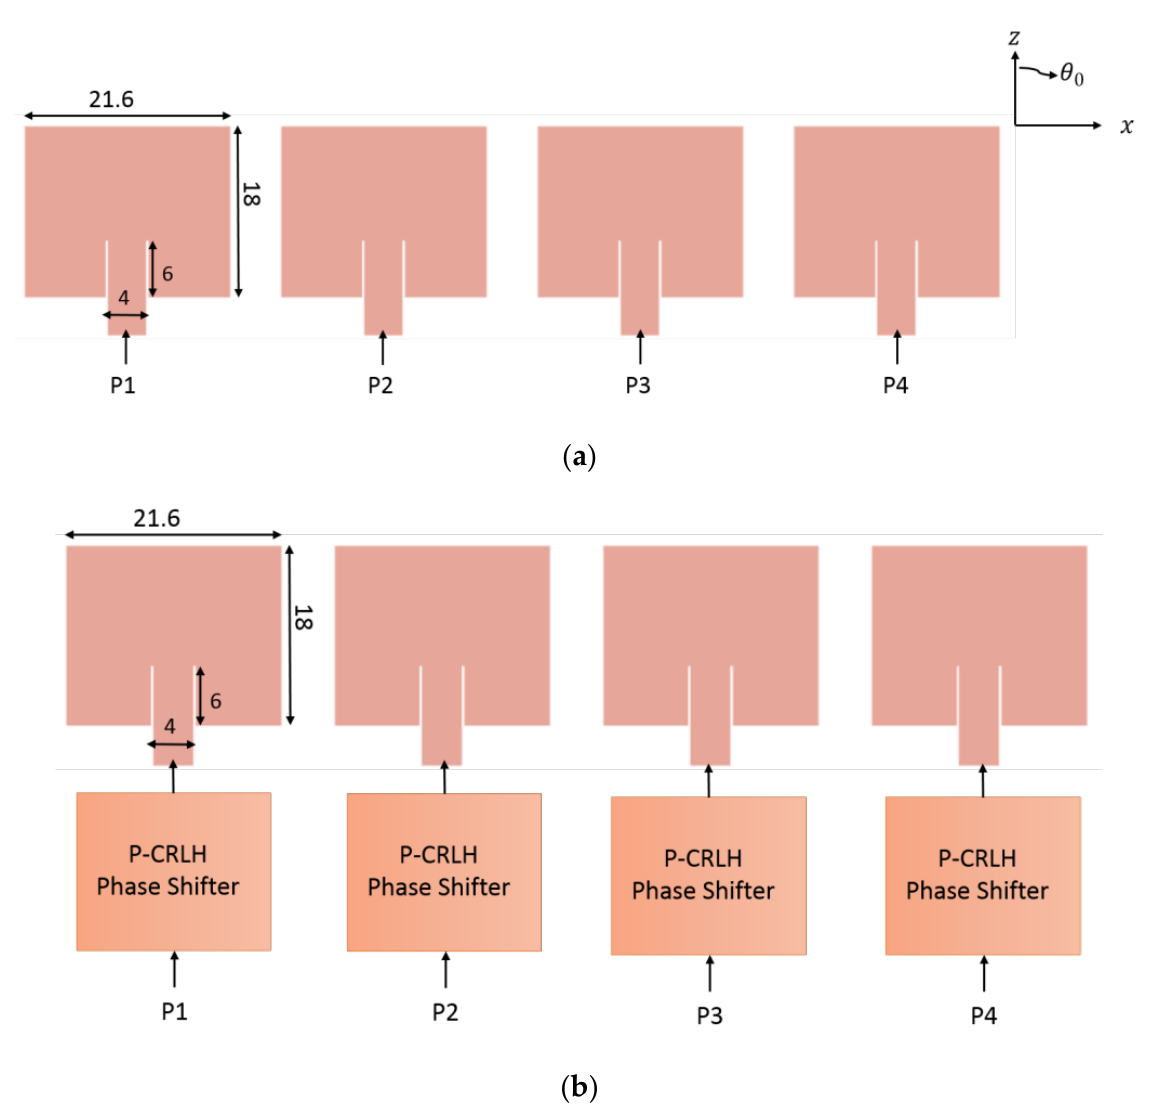
Figure 8. A 1 × 4 linear phased array with: ( a ) directly excited phases and ( b ) P-CRLH-excited phases.